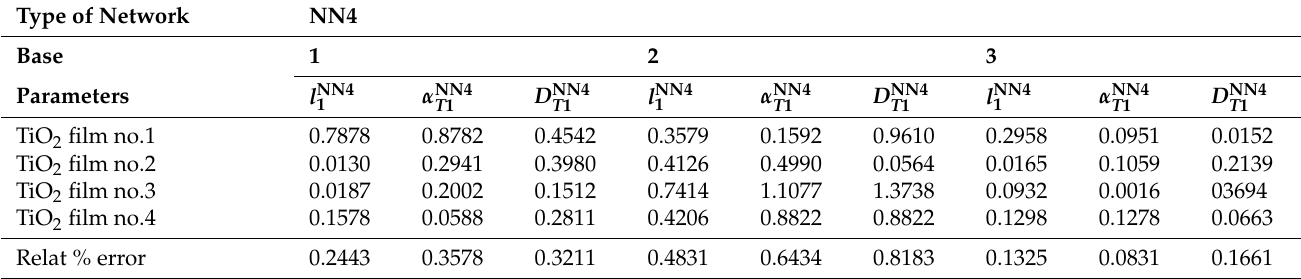
Table 3. Relative (%) error prediction of TiO 2 thin-film parameters NN4 on 4 signals from three bases “in-step” of training